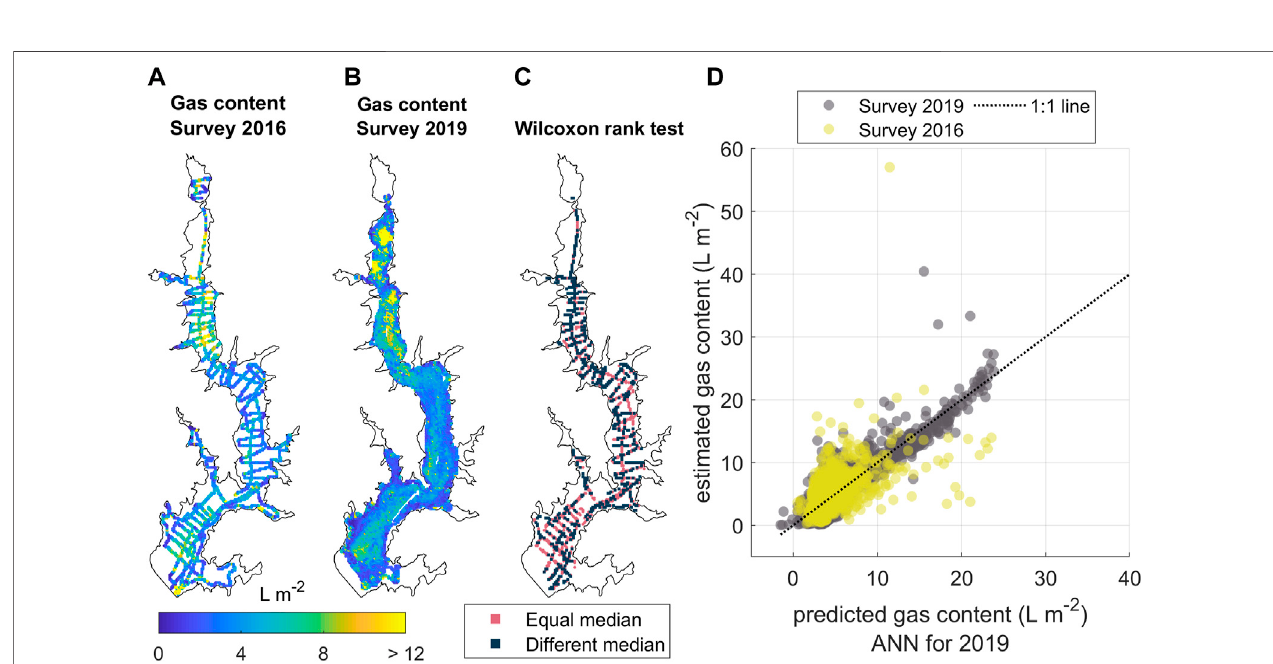
FIGURE 6 | (A) Areal gas content in the sediment for the 2016 acoustic survey. (B) Gas content in the sediment for the 2019 survey. (C) Results of the Wilcoxon rank test comparing the median gas content from both years, in which pink dots mark grid cells for which the null hypothesis of data from both years having the same distribution and equal median is accepted, and the dark blue dots mark the grid cells where the null hypothesis was rejected. (D) Scatter plot of observed vs. predicted gas content by the arti fi cial neural network model with data from 2016 (yellow dots) and 2019 (grey dots). The dotted black line shows a 1:1 relationship.